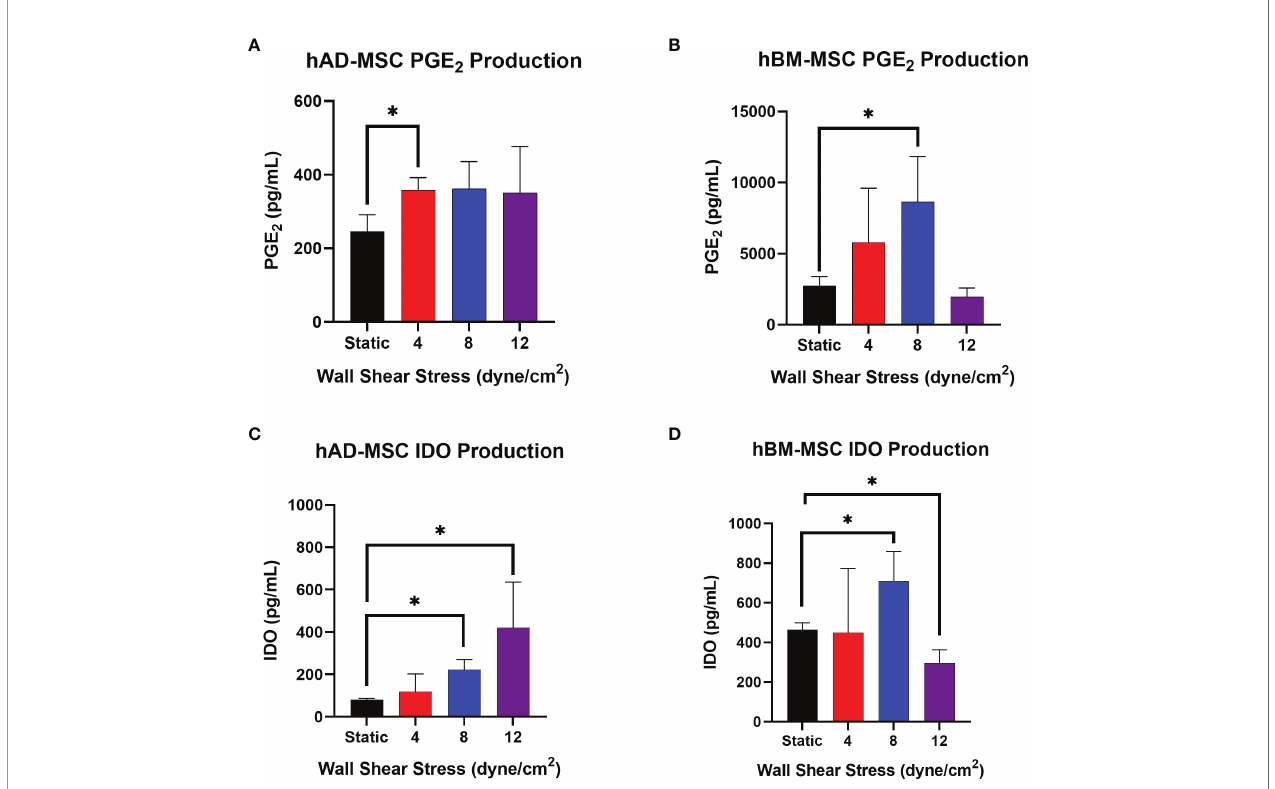
FIGURE 4 | Select WSS-exposure enhances production of PGE 2 and IDO by hAD-MSC and hBM-MSC. (A, B) The accumulation of PGE 2 in conditioned media from hAD-MSC and hBM-MSC cultures, respectively, plated at 200,000/mL, was assayed after an 18 hr incubation using ELISA (n=3 independent experiments; unpaired t-test, *p<0.05). Data represent Mean ± SD. (C, D) The concentration of IDO in conditioned media from hAD-MSC and hBM-MSC cultures plated at 200,000/mL was determined after 18 hrs incubation using ELISA (n=3 independent experiments; unpaired t-test,